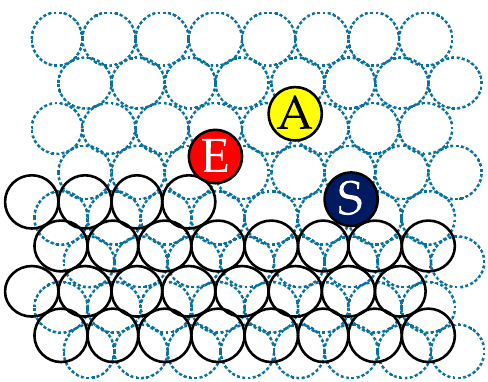
Figure 5. Schematic of adsorption conditions. A, E, and S particles are those that form respectively three, four, and five bonds with particles in a crystal. Dotted and solid circles represent the lower and upper layers, respectively.